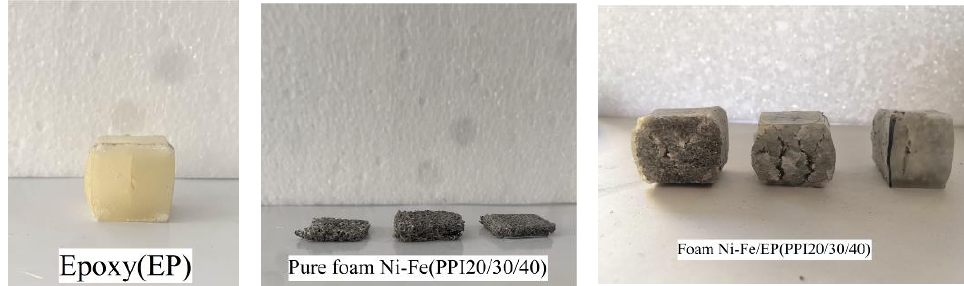
Figure 5. Damage morphologies of the pure epoxy, foam Ni-Fe, and foam Ni-Fe/EP interpenetrating phase composites. phase